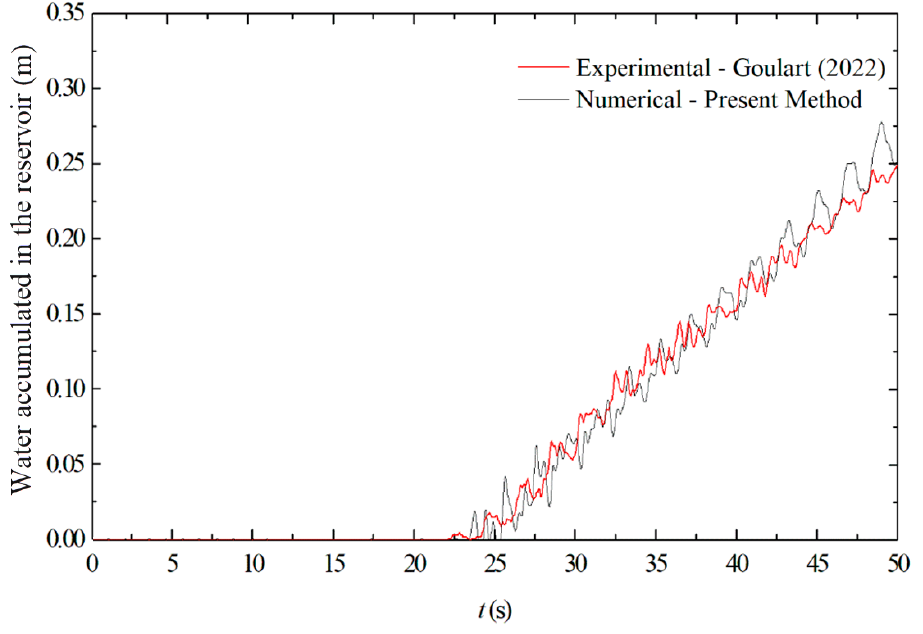
Figure 7. Water accumulated in the reservoir of laboratory-scale overtopping device as function of time obtained experimentally in Goulart [45] and with the present numerical method.